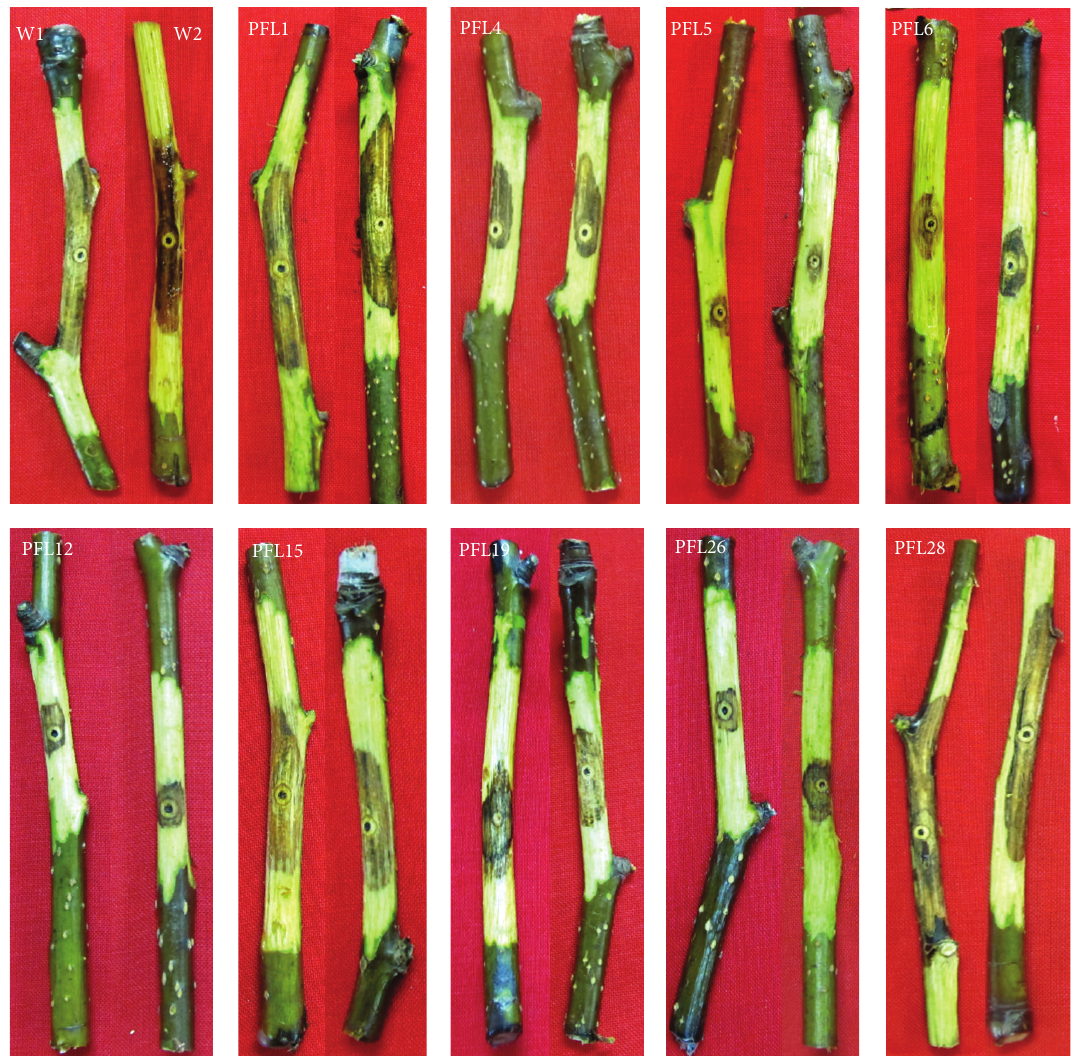
Figure 6: Lesions caused by Valsa mali wild-type strain LXS240101 and transformants in Pyrus pyrifolia (Burm. f.). cv. Nakai seven days after inoculation on two-year-old twigs using conidia suspensions or mycelium plugs. W1, PFL4, PFL5, PFL12, PFL19, PFL26, and PFL28 were inoculated using 100uL conidia suspensions (10 6 /mL). W2, PFL1, PFL6, and PFL15 were inoculated using mycelium plugs (diameter 6mm). The lesions caused by the transformants were different in